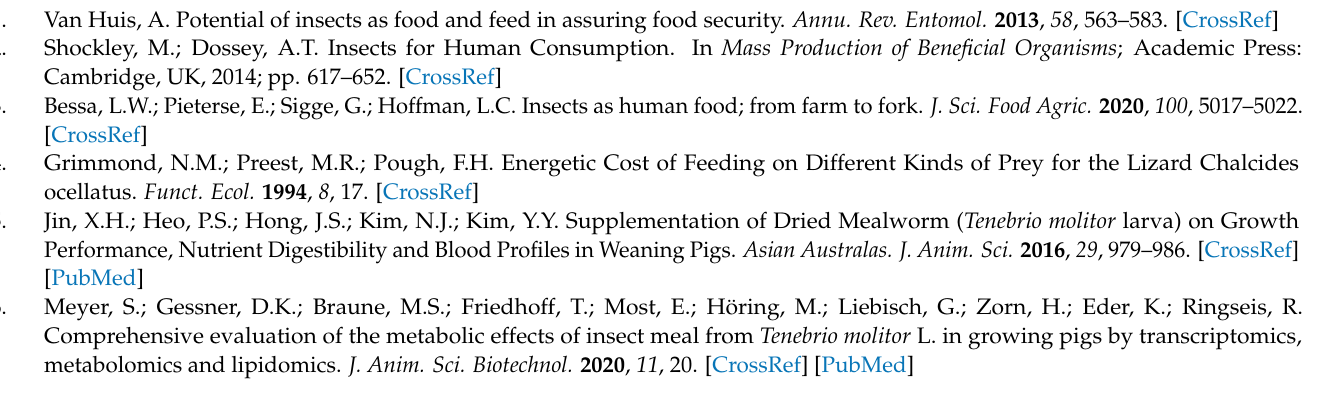
Table S2: Amino acid composition of the substrates on a dry matter (DM) basis (%) used for Tenebrio molitor diets; Table S3: Orthogonal contrasts ( p -values) of growth performance, feed and protein utilization efficiency and survival rate of Tenebrio molitor larvae of different feeding groups; Table S4: Orthogonal contrasts ( p -values) of nutritional composition of Tenebrio molitor